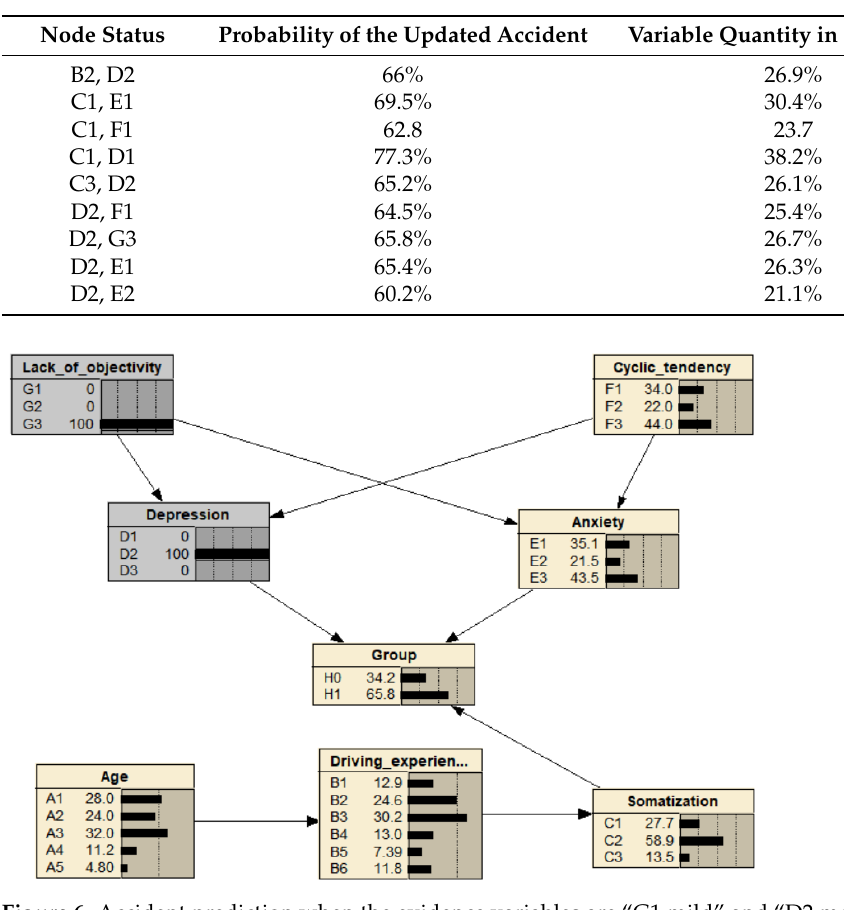
Figure 6. Accident prediction when the evidence variables are “G1 mild” and “D2 moderate”.